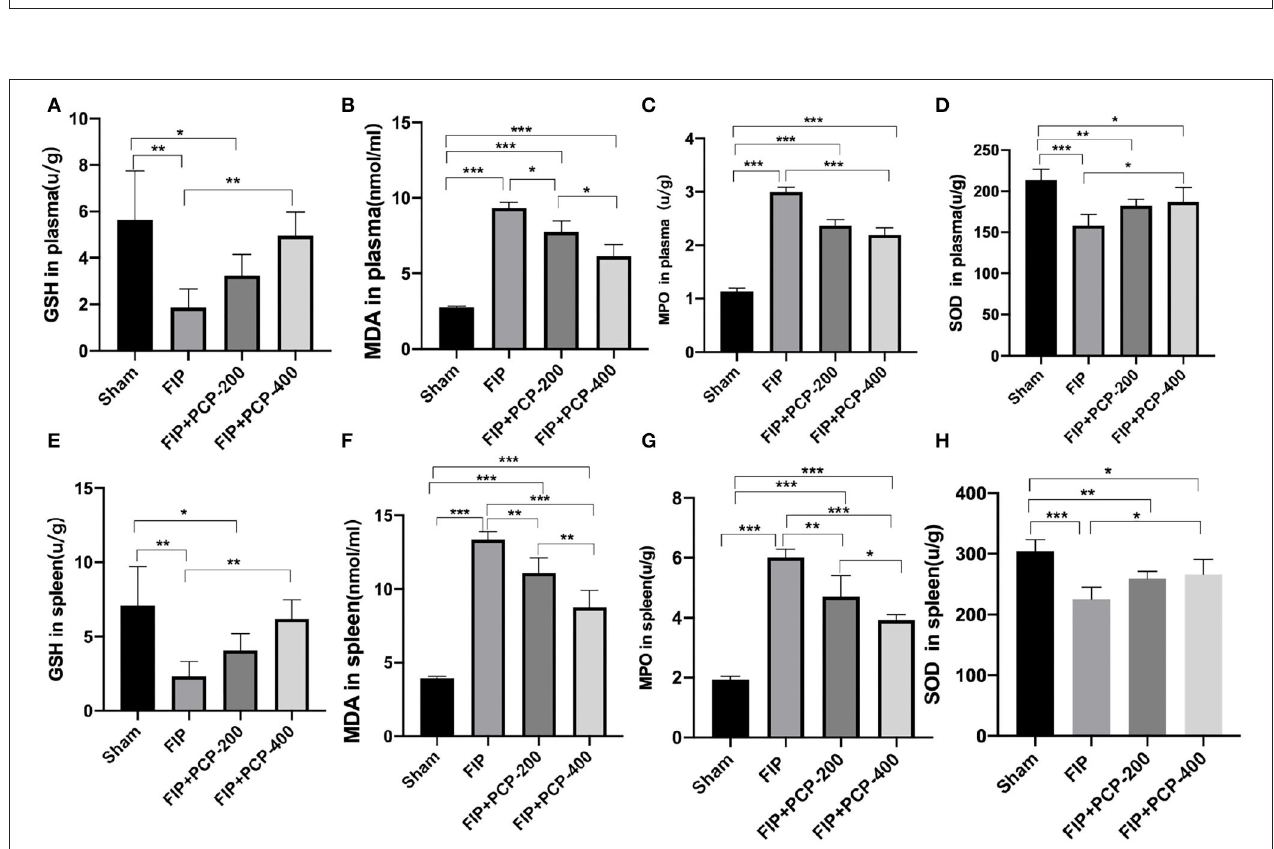
FIGURE 4 | PCP pretreatment inhibited the oxidative stress in fecal peritonitis-induced septic mice. (A) GSH in plasma in each group. (B) MDA in plasma in each group. (C) MPO in plasma in each group. (D) SOD in plasma in each group. (E) GSH in the spleen in each group. (F) MDA in the spleen in each group. (G) MPO in the spleen in each group. (H) SOD in the spleen in each group. * P < 0.05; ** P < 0.01, *** P < 0.001, FIP + PCP-200 = FIP with PCP 200 mg/kg/day; FIP + PCP-400 = FIP with PCP 400 mg/kg/day. All presented data are a composite of three independent experiments. n = 5 in each group.